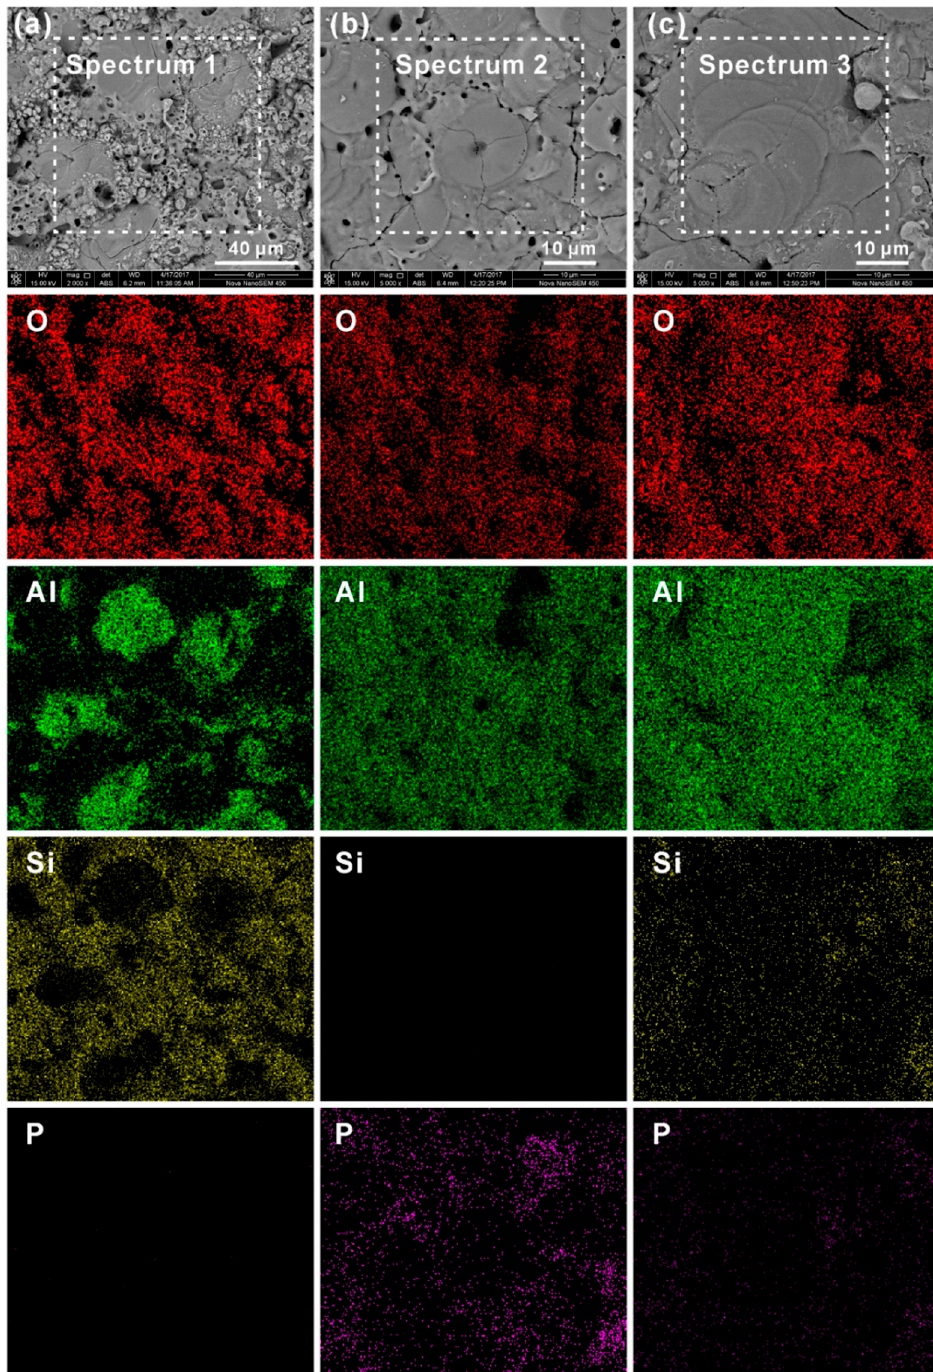
Figure 9. Depiction of surface morphology and distribution of elements for PEO coating produced by ( a ) silicate electrolyte, ( b ) phosphate electrolyte, and ( c ) mixed electrolyte of silicate and phosphate. Reproduced with permission from [40]. Copyright Elsevier, 2020.